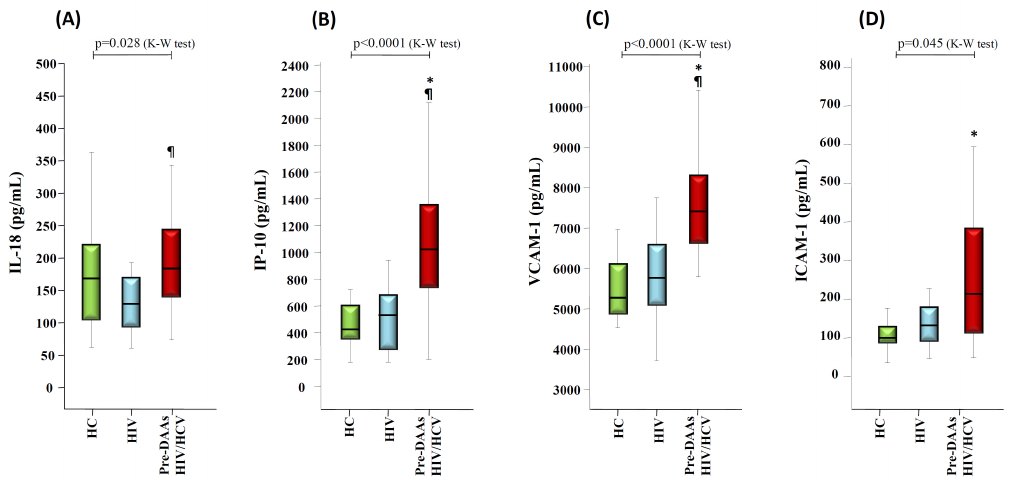
Figure 1. Box-plots graphs showing the levels of IL-18 ( A ), IP-10 ( B ), vascular cell adhesion molecule 1 (VCAM-1) ( C ) and intercellular adhesion molecule 1 (ICAM-1) ( D ) in healthy controls (HC) donors, HIV monoinfected (HIV), and in HIV/ hepatitis C virus (HCV) coinfected patients before direct-acting antivirals (DAAs) treatment (pre-DAAs HIV/HCV). p -values for global comparison between the groups (Kruskal-Wallis test, K-W) are shown. ( * ): p < 0.05 with respect to HC donors (Mann-Whitney U test). ( ¶ ): p < 0.05 with respect to the HIV group (Mann-Whitney U test).